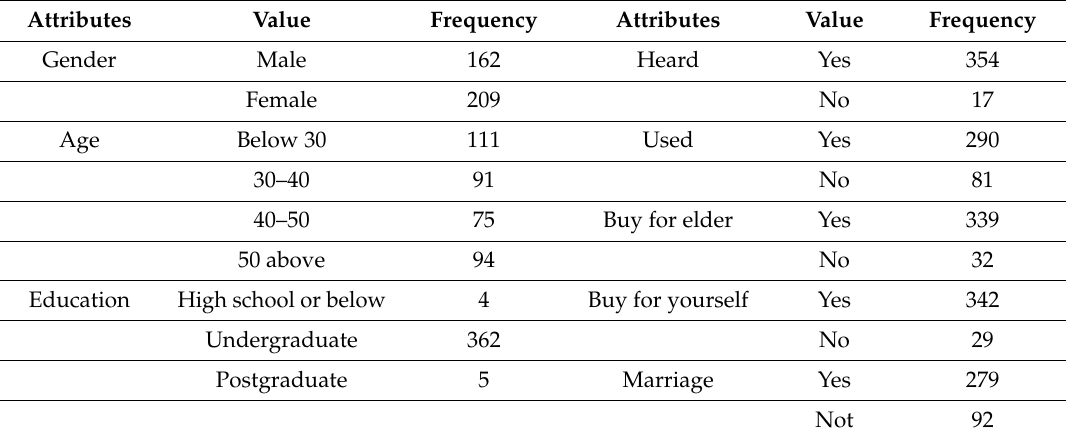
Table 3. Sample demographic